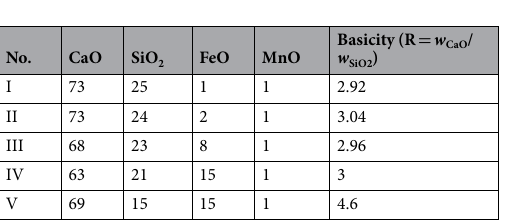
Table 2. Slag composition, wt.%.